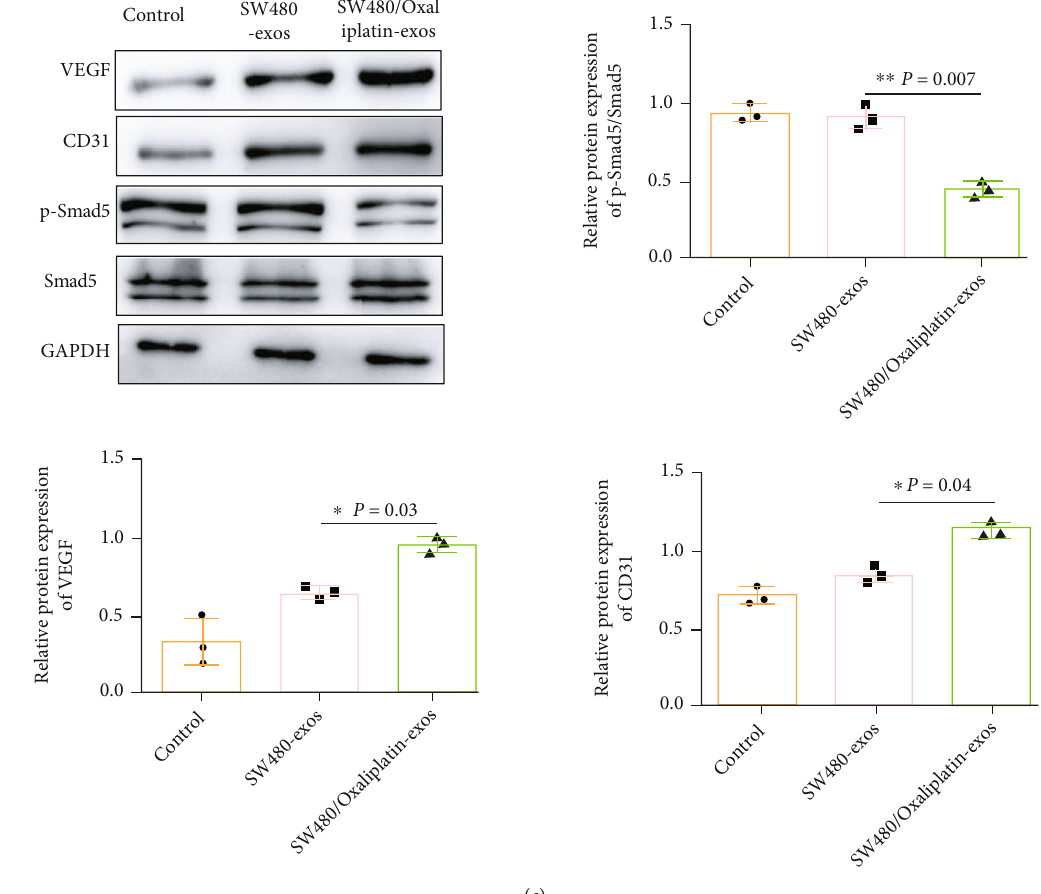
Figure 4: SW480/oxaliplatin cell-derived exosomes accelerates angiogenesis. Exosomes were extracted from SW480/oxaliplatin and SW480 cells and then co-cultured with HUVECs. (a) The Transwell assay determined the HUVECs migration. (b) Photomicrographs of tube-like structures and quanti fi cation of the tube number. (c) The protein expression of CD31, VEGF, and phosphorylation Smad5 in HUVECs. All the above experiments were repeatedly performed 3 times; data are shown as the means ± SD . ∗ P < 0 : 05 , ∗∗ P < 0 : 01